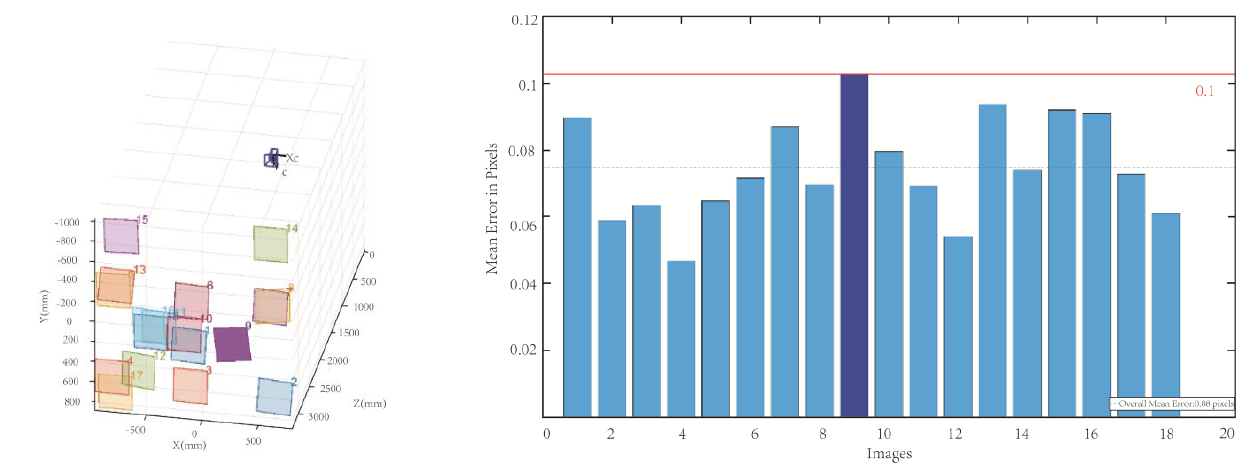
Figure 7. Calibration plate attitude and calibration average projection error. Table 2. Calibration results of camera internal parameters.